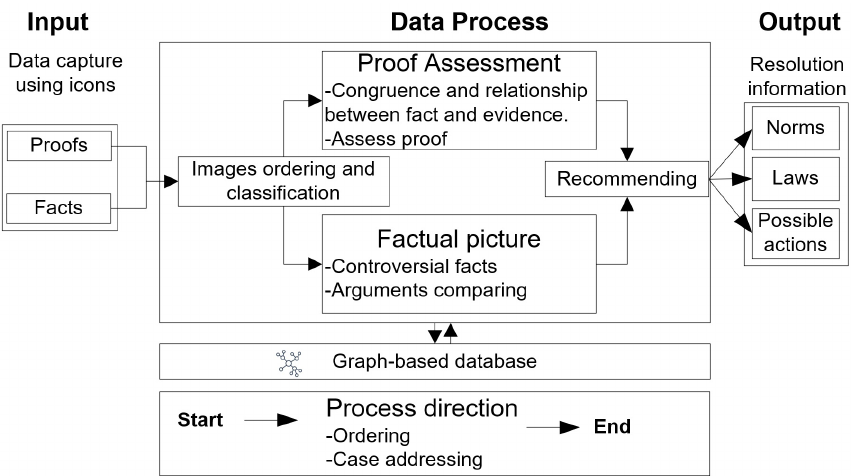
Figure 2. Data overview diagram of the system: Image inputs, evidence and facts processing, and norms and laws